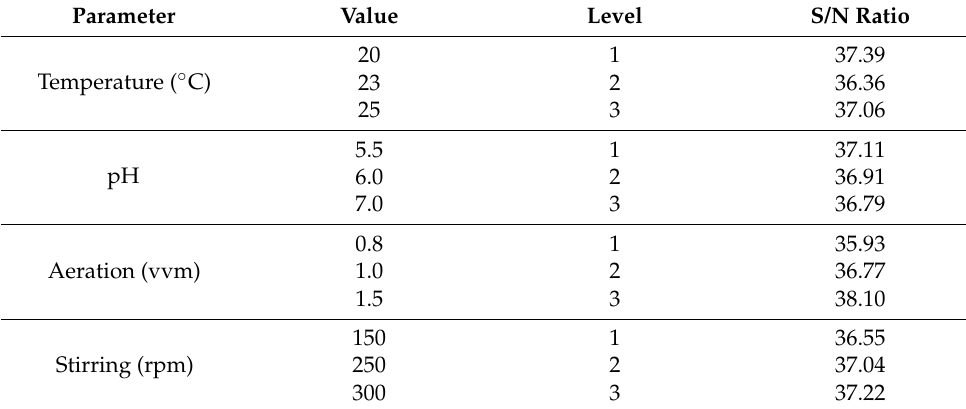
Table 2. S/N ratio response table for controlled